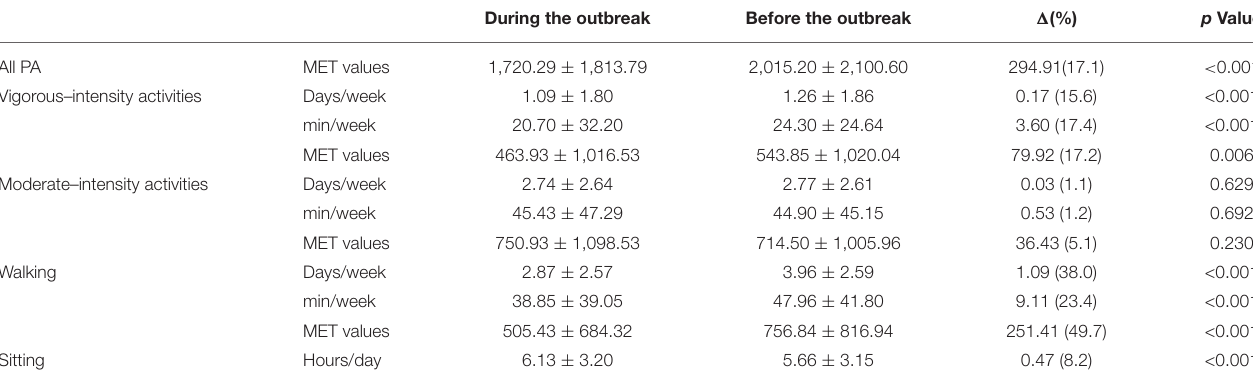
TABLE 2 | IPAQ-SF responses before and during the